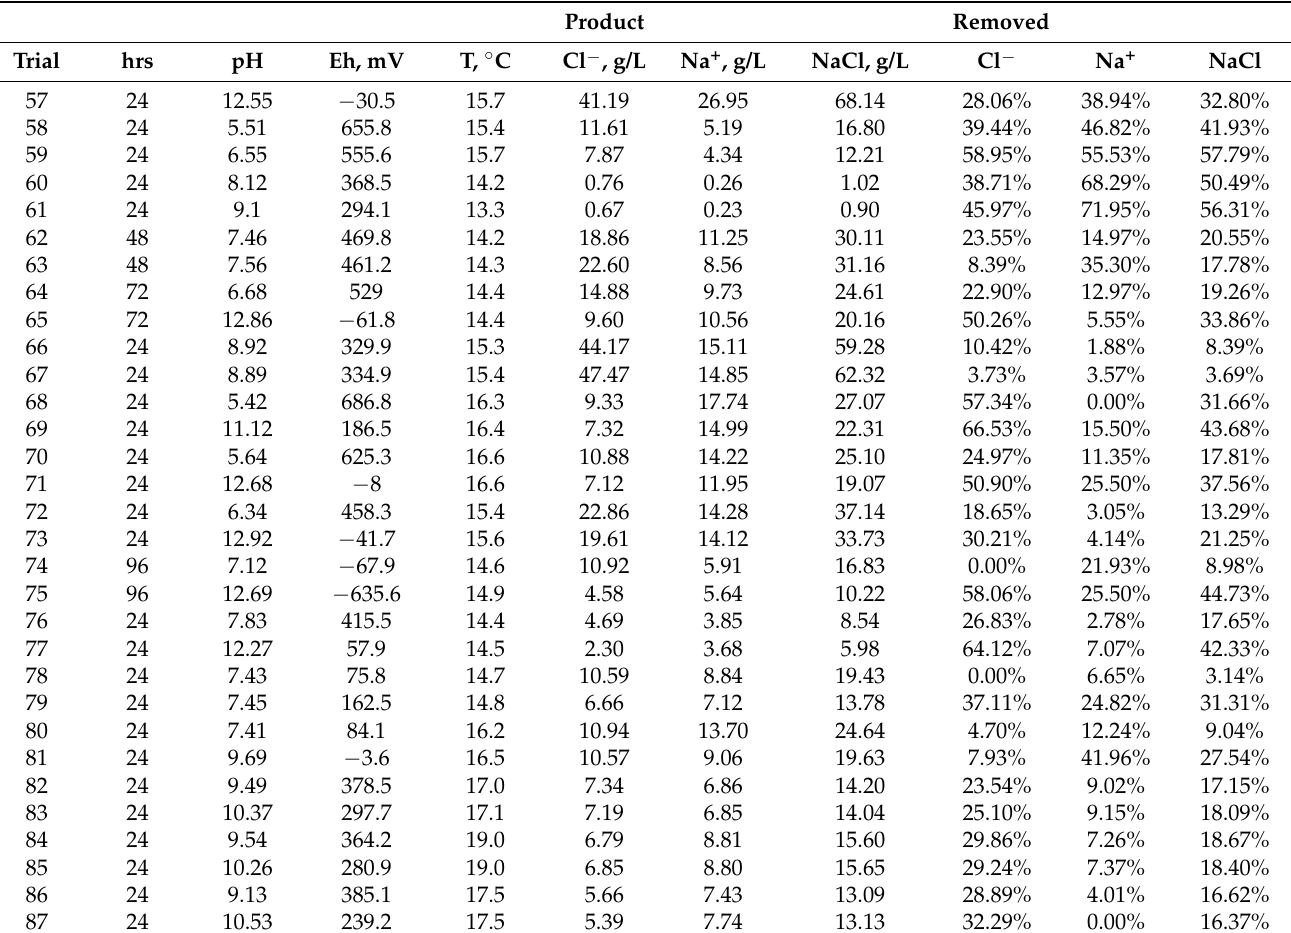
Table A3. Inorganic polymer ingredients: Inorganic solutes, g/L; 1 = FeSO 4 ; 2 = MgSO 4 ; 3 = Al 0